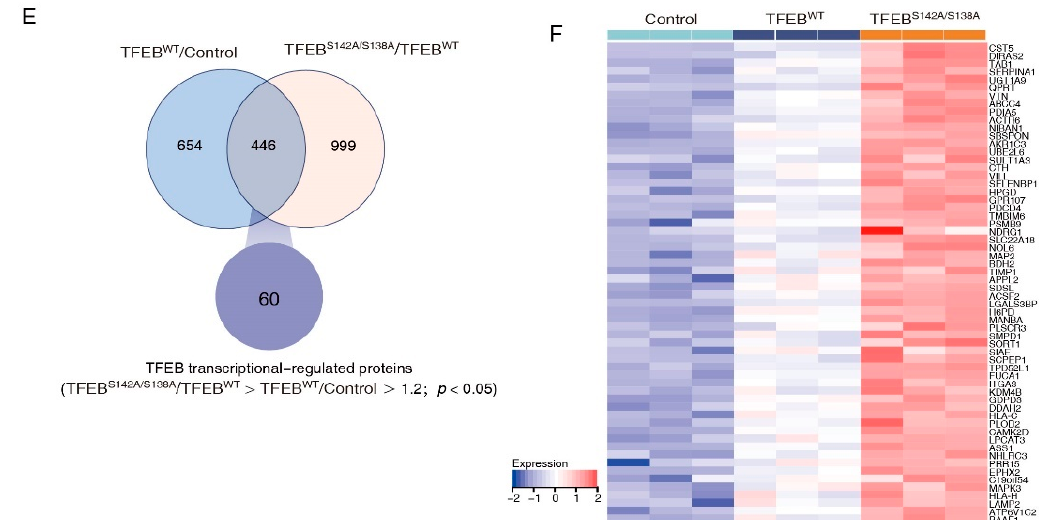
Figure 2. DIA-based quantitative proteomics characterizes TFEB targets. ( A ) The workflow of three independent DIA-MS experiments for identification of the TEFB-regulated proteins. ( B ) Ridge plots showing protein expression distribution in each group. ( C ) PCA analysis demonstrating that samples in the control, TFEB WT , and TFEB S142A/S138A were separated into three discrete groups. ( D ) Volcano plot showing the DEPs in TFEB S142A/S138A versus TFEB WT and TFEB WT versus control comparisons. ( E ) Venn diagram showing 60 TFEB targets. ( F ) Heatmap showing the expression of TFEB-regulated proteins in the control, TFEB WT , and TFEB S142A/S138A ,